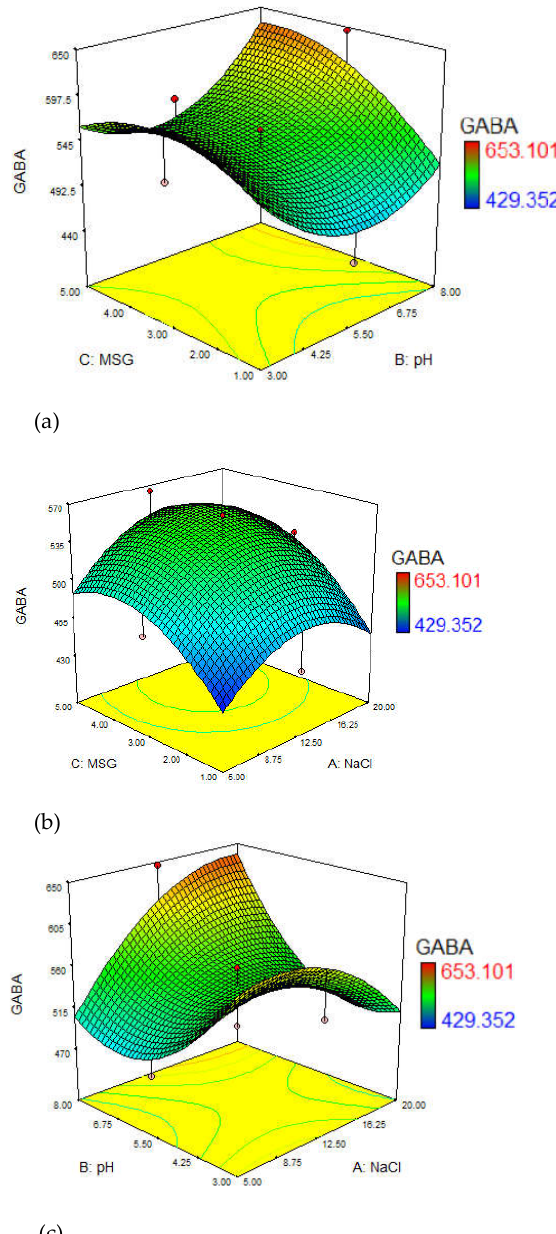
Figure 4. The 3D surface plot demonstrating the effects between ( a ) MSG and pH, ( b ) NaCl and MSG, and ( c ) NaCl and pH on GABA yield by THSK.